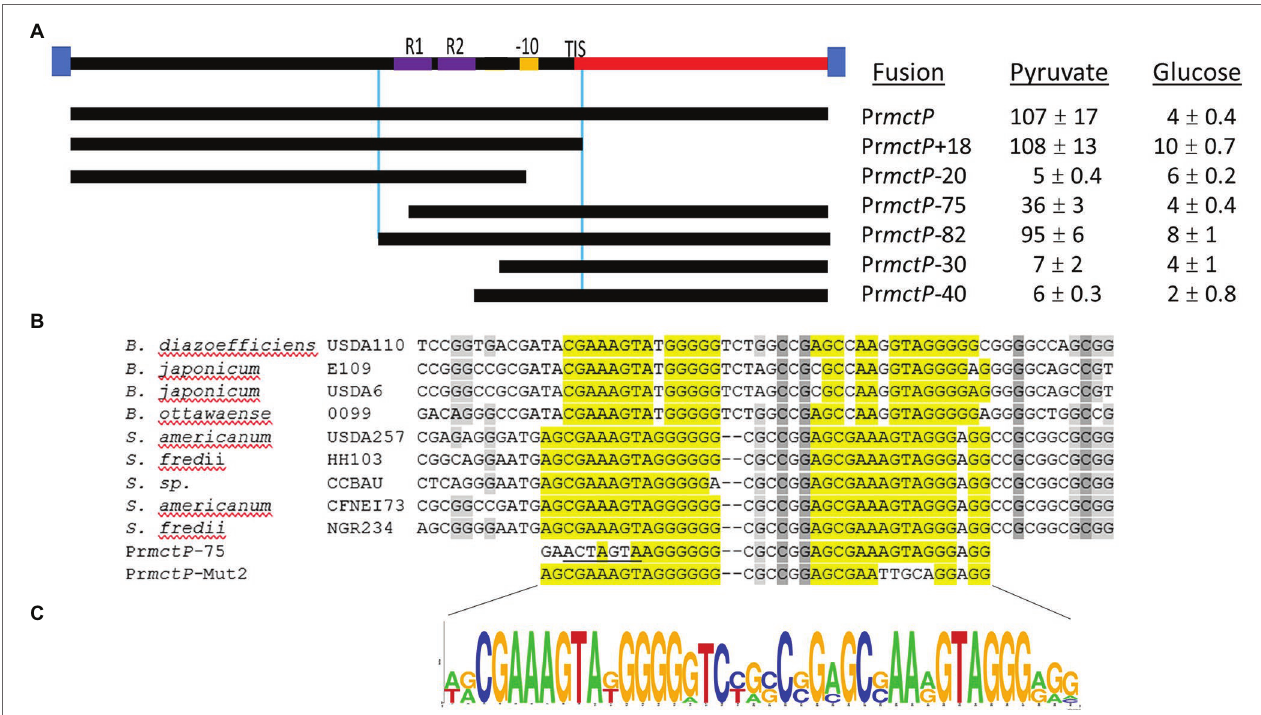
FIGURE 5 | Mapping of the NGR_RS10970- mctP operon promoter. (A) Activities of in-trans transcriptional fusions of the NGR_RS10970- mctP operon promoter and its derivatives in a wild-type strain growing on pyruvate or glucose as sole carbon sources. Miller units are expressed as means ± Standard deviations of results from at least three independent experiments. (B) Sequence of the mctP operon promoter in different members of the Rhizobiaceae and of the mctP derivatives with mutations in the first (Pr mctP -75) and second (Pr mctP -Mut2) repeat. (C) Sequence Logo of the identified direct repeat obtained from the aligned sequences of